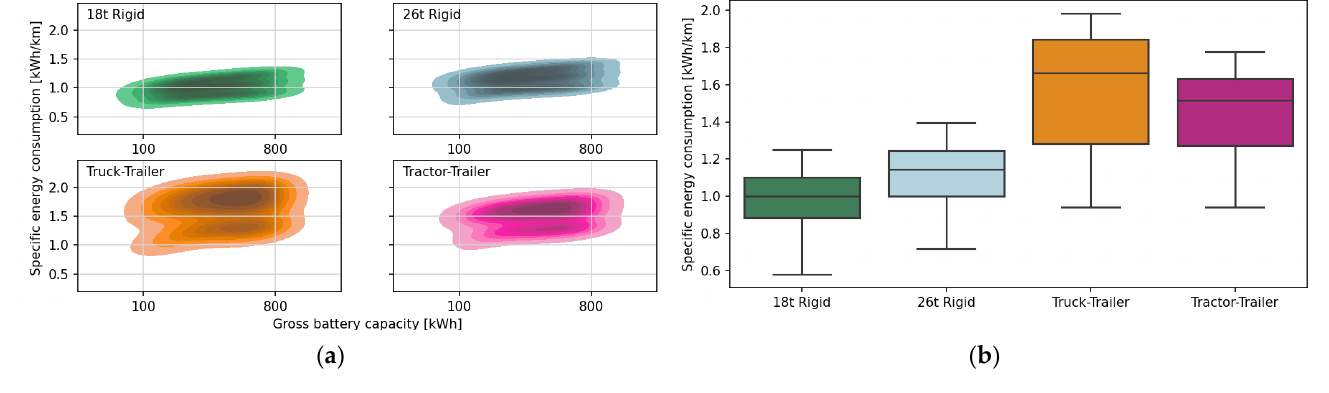
Figure 4. Trip-averaged specific energy consumption [kWh/km] per truck class. ( a ) Density plot over battery capacity ( b ) Sample-weighted boxplot per truck class. Boxplots indicate the lower quartile, median, upper quartile, and whiskers (±1.5 IQR); Colors indicate different truck classes: 18-t rigid (green), 26-t rigid (blue), tractor-trailers (purple),and truck-trailers (orange)—own illustration.